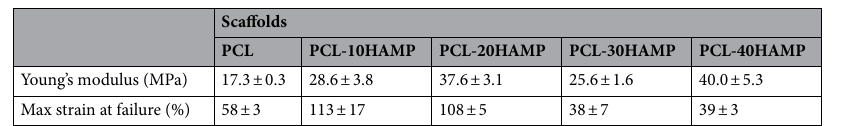
Table 3. The Young’s modulus and elongation-at-break values of the scaffolds.